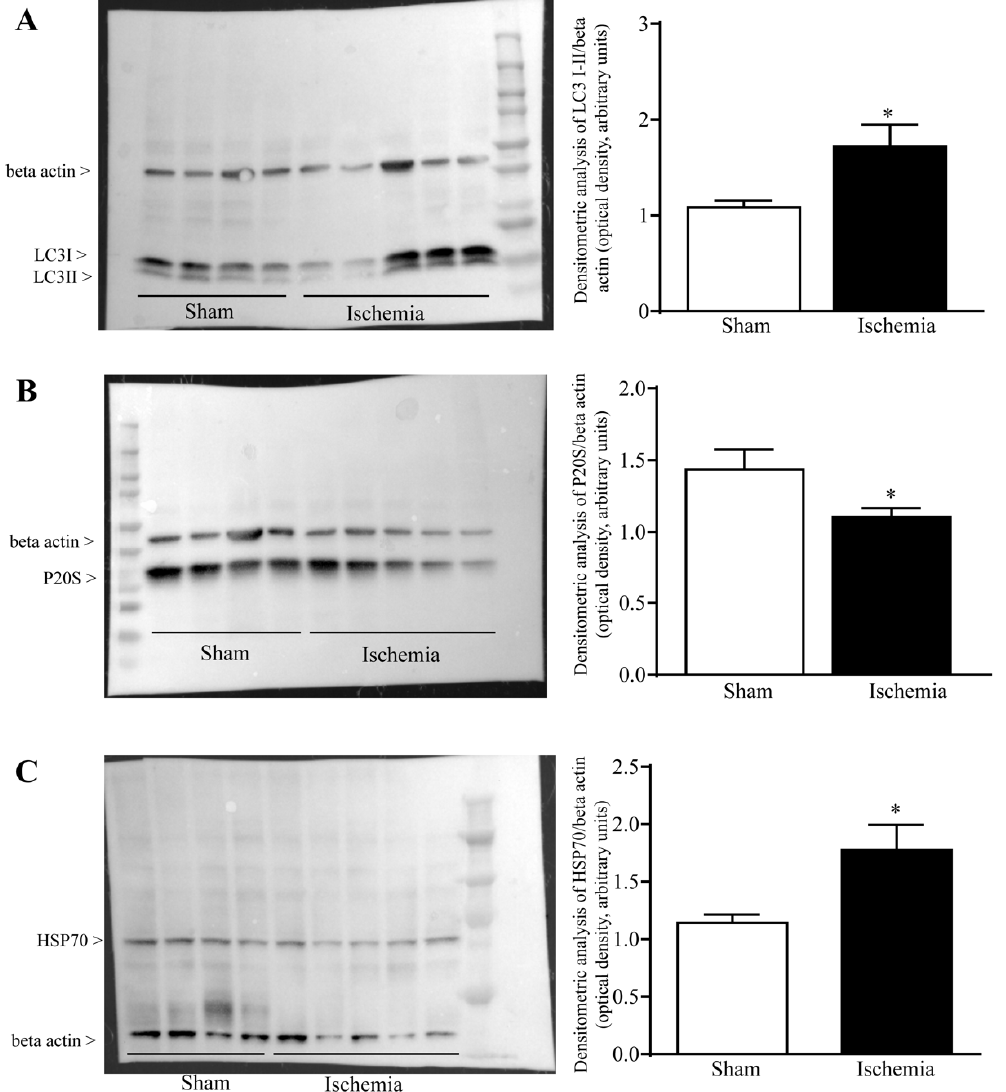
Figure 8. Modulation of LC3, P20S and HSP70 proteins following ischemia. Representative Western Blotting for LC3 ( A ), P20S ( B ), HSP70 ( C ) and beta actin within the area penumbra (Ischemia, in the representative picture) compared with the homologous area from a control mouse (Sham). Each graph reports the semi-quantitative densitometric analysis of each antigen expressed compared with the house-keeping protein beta actin. ( A ) df = 7, t = 2.396, p = 0.0478; ( B ) df = 7, t = 2.367, p = 0.0498; ( C ) df = 7, t = 2.433, p = 0.0452, * p ≤ 0.05 compared with Sham.